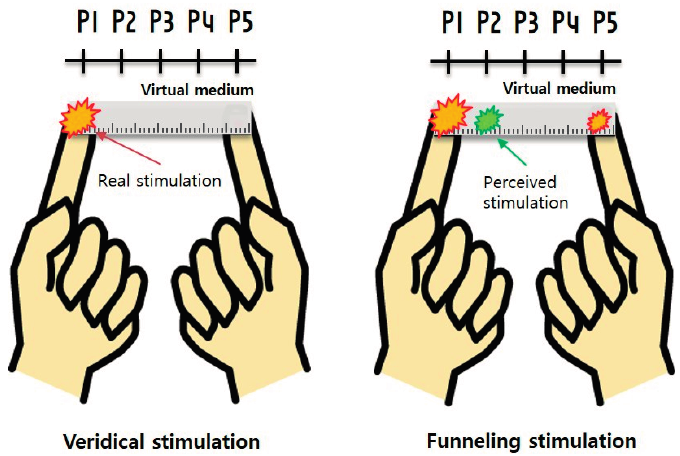
Figure 3. The two conditions in the experiment: veridical stimulations on the fingertips at P1 and P5 (note that P1 and P5 are where the vibrators are actually located) and funneling stimulation to induce illusory sensation at P2–P4 with the virtual object seen to connect the